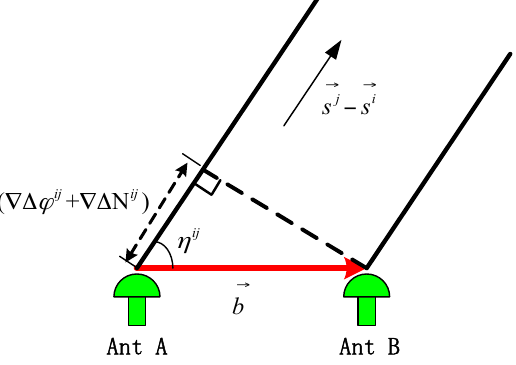
Figure 2. Illustration of the measurement of the DD carrier phase.